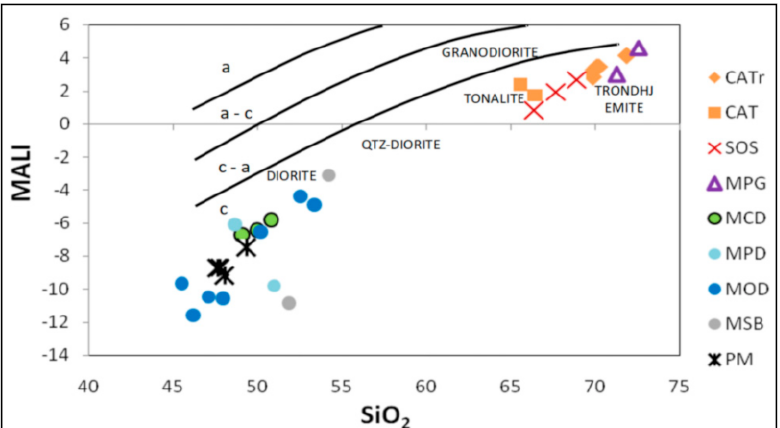
Figure 9. MALI classification diagram as a function of SiO 2 [78]. MALI stands for modified alkali–lime index (Na 2 O + K 2 O–CaO). CATr = Corno Alto trondhjemite, CAT = Corno Alto tonalite, SOS = Sostino granodiorite, MPG = Monte Palone granite, MCD = Malga Campo diorite, MPD = Malga Persec diorite, MOD = Monte Ospedale diorite, MSB = Malga Seniciaga Bassa diorite, PM = Parental melts. PM samples are Re di Castello Parental Melts after